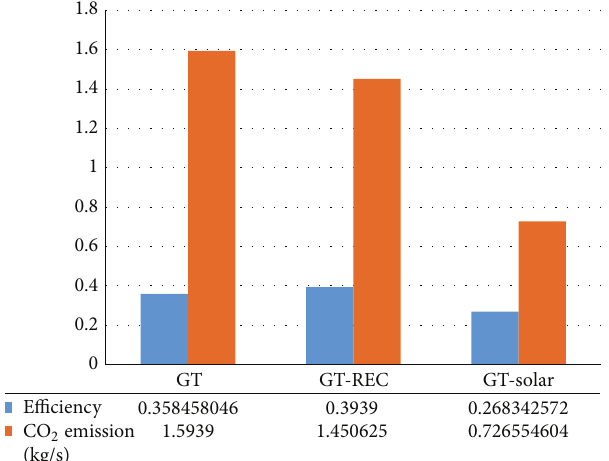
Figure 4: Exergy destruction distribution in GT-recuperator cycle.